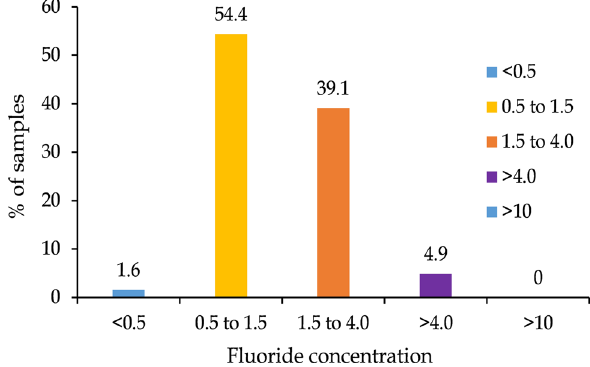
Fig. 5 Fluoride classification in the groundwater of Markapur region, India